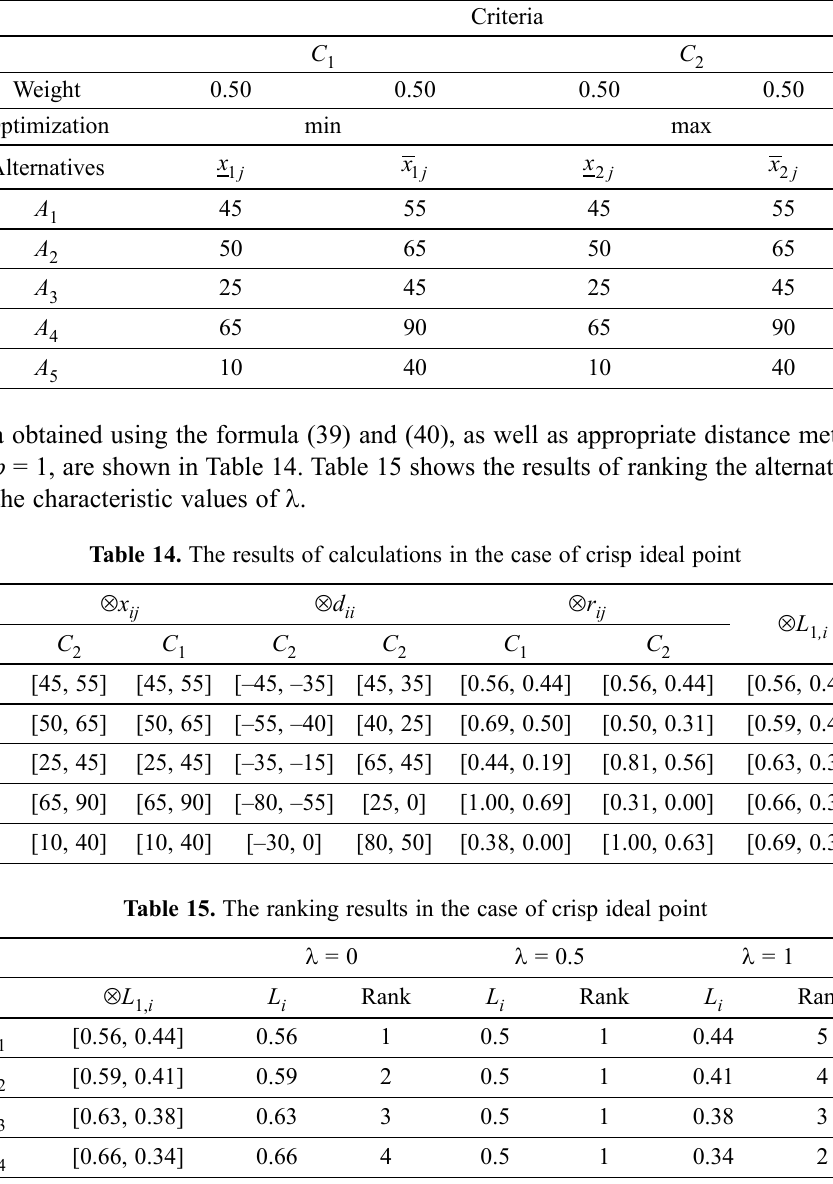
Table 13. The data used for the evaluation of alternatives